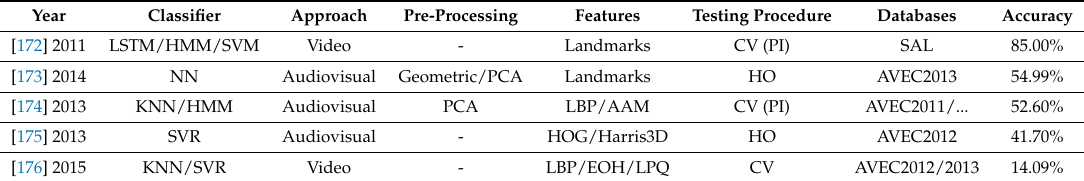
Table 6. Results of reviewed works based on the circumplex